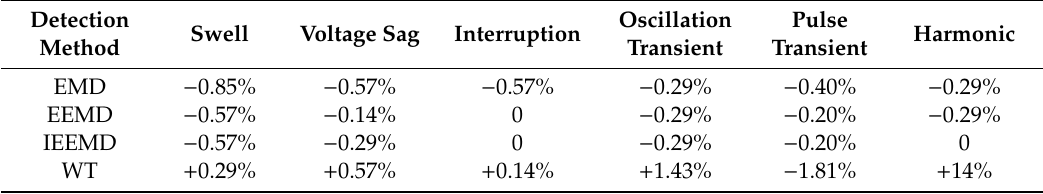
Table 4. The relative error of the disturbances start time point.